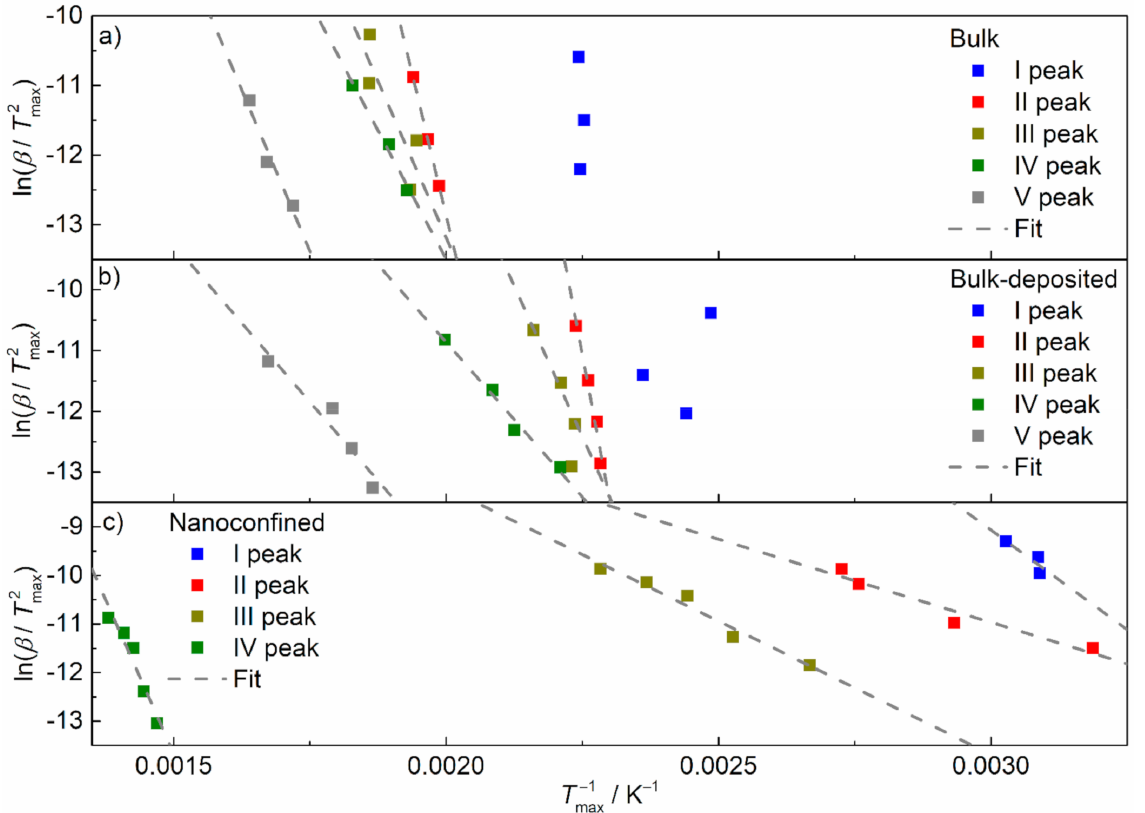
Figure 3. Kissinger equation plots of ( a ) bulk, ( b ) bulk-deposited, and ( c ) nanoconfined NaAlH 4 and the corresponding fits to the T max of H 2 release processes obtained from fitting the H 2 release curves with gaussian and bigaussian peak